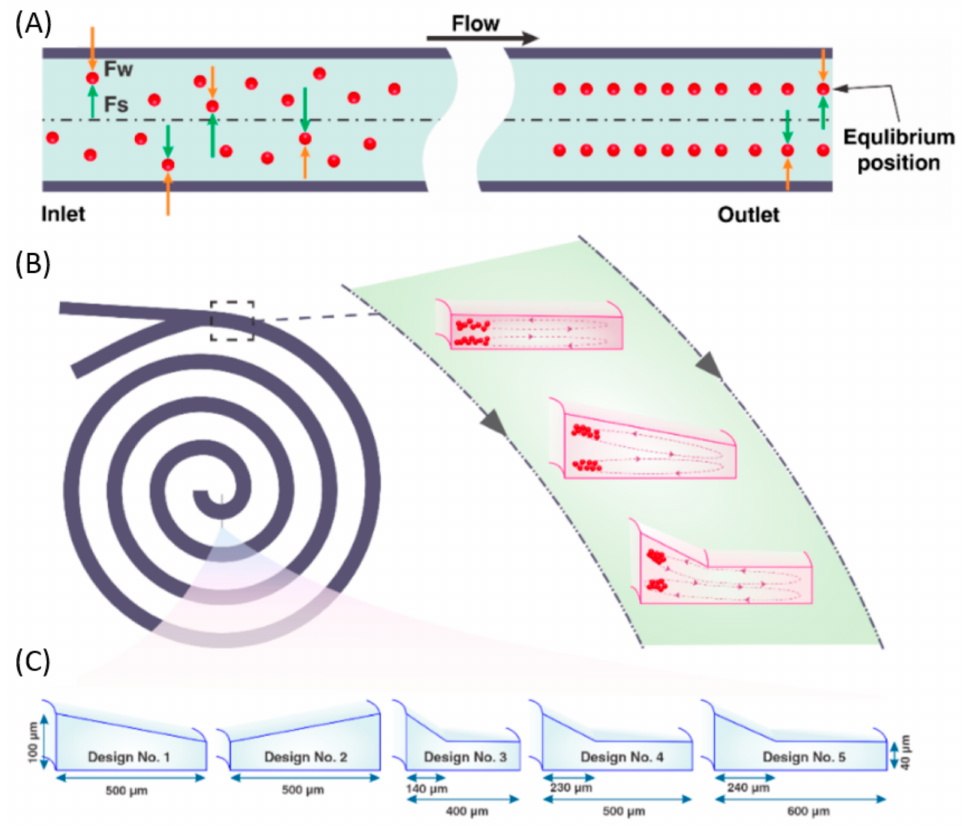
Figure 15. ( A ) The schematic illustration of particle focusing in straight rectangular microchannels. ( B ) Schematic of spiral microchannels. ( C ) Schematic of a cross-sectional view of the channels used in the work of Mihandoust et al. Reprinted from an open-access source